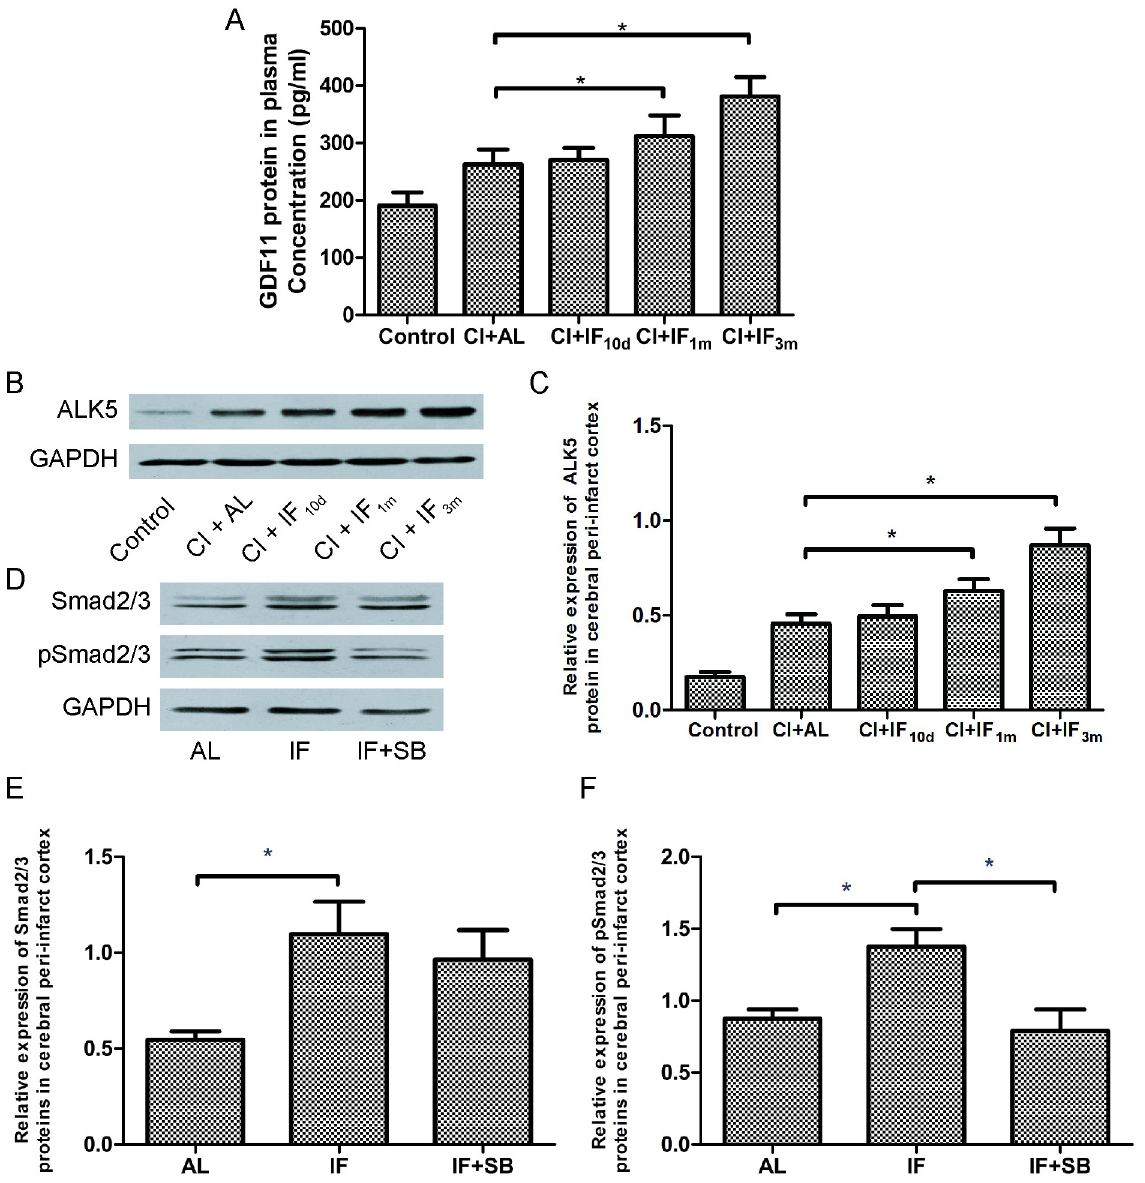
Fig 3. Long-term IF conditioning activates GDF11/ALK5/ Smad2/3 pathways after CI. ( A ) IF upregulates the expression level of circulating GDF11 3 d after CI. Bar graph showing GDF11 protein in plasma in the 5 groups as indicated by ELISA. * p < 0.01 compared with the CI + AL group (n = 8 /group). ( B ) IF upregulates the expression level of cerebral ALK5 3 d after CI. Representative images of western blot showing ALK5 expression in the peri-infarct area from the first step of this study. ( C ) Bar graph showing ALK5 protein expression level (relative to GAPDH) in the 5 groups. * p < 0.01 compared with the CI + AL group (n = 8/group). ( D ) Representative images of western blot showing total Smad2/3 and pSmad2/3 expression in the peri-infarct area 7 d after CI from the second step of this study. Bar graph showing Smad2/3 ( E ) and pSmad2/3 ( F ) protein expression levels (relative to GAPDH) in the 3 groups. * p < 0.01 compared with the IF group (n =